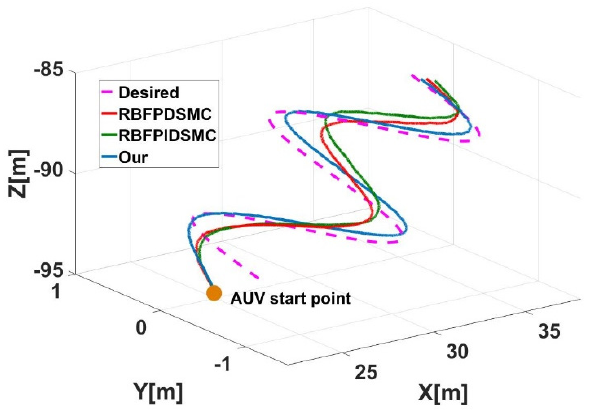
Figure 16. Three − dimensional view of the trajectory.